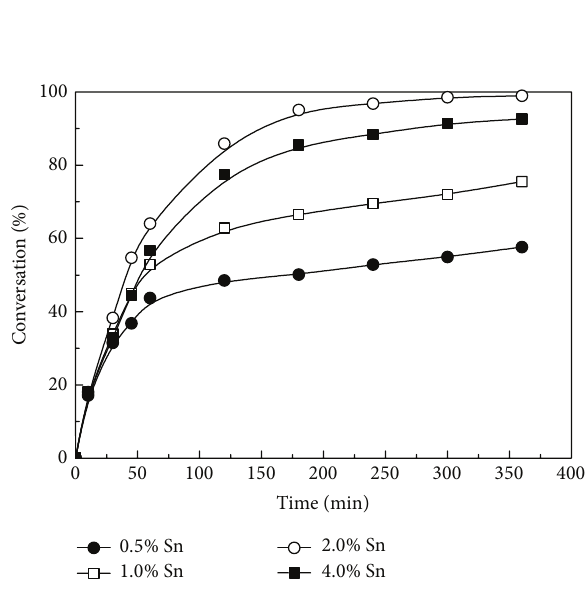
Figure 6: Conversion of methyl oleate as a function of time. Bimetallic catalysts.